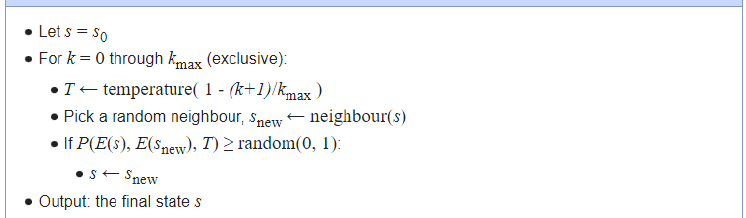
Figure 2. Simulink AGC components for two-area power system.